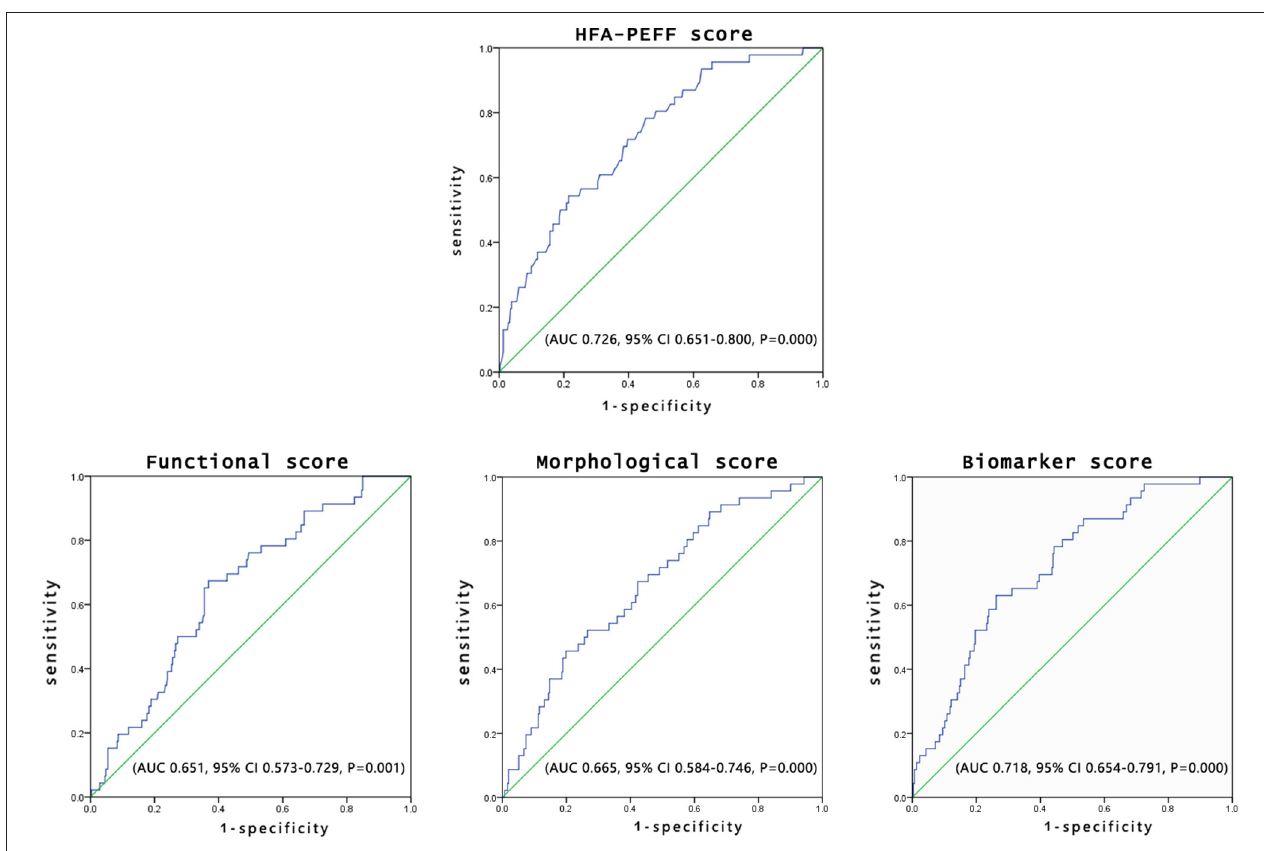
FIGURE 4 | Prognostic performance of HFA-PEFF score and domain